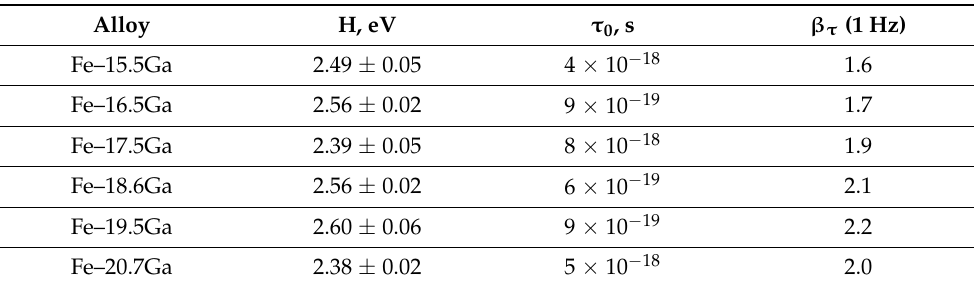
Table 1. Apparent values of the activation parameters for the P2 Zener relaxation in Fe–(15–21)Ga alloys [59].